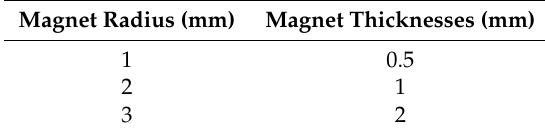
Table 1. Parameters of Magnet geometry in the magnetic field simulation, all combinations of parameter were